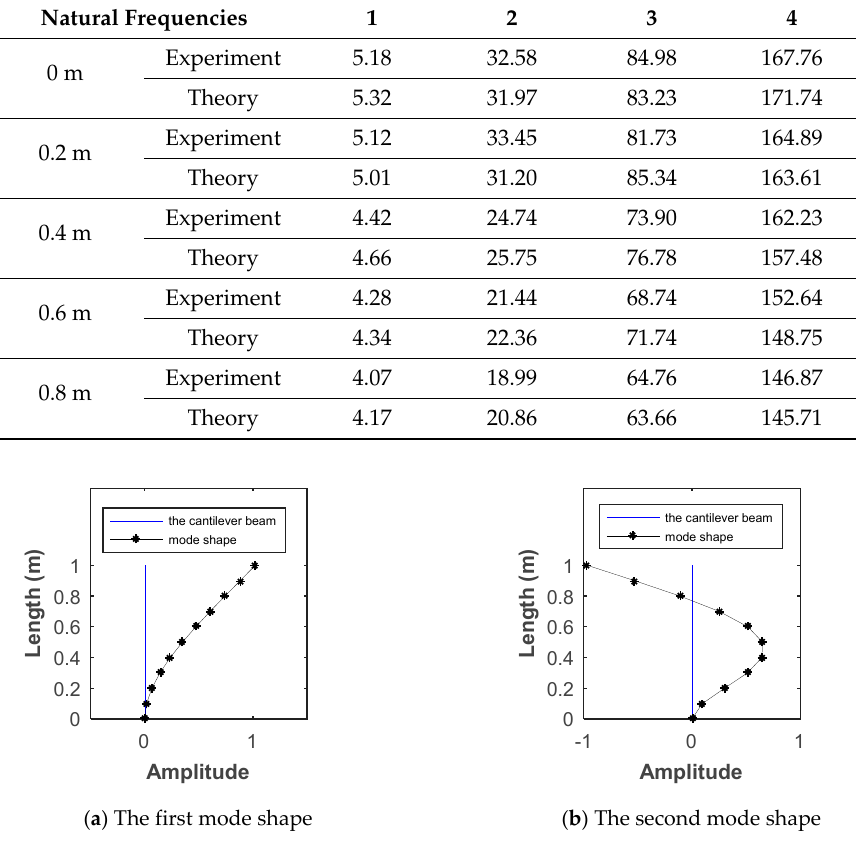
Figure 8. The first two shapes of the cantilever beam with 0.4 m immersion depth.